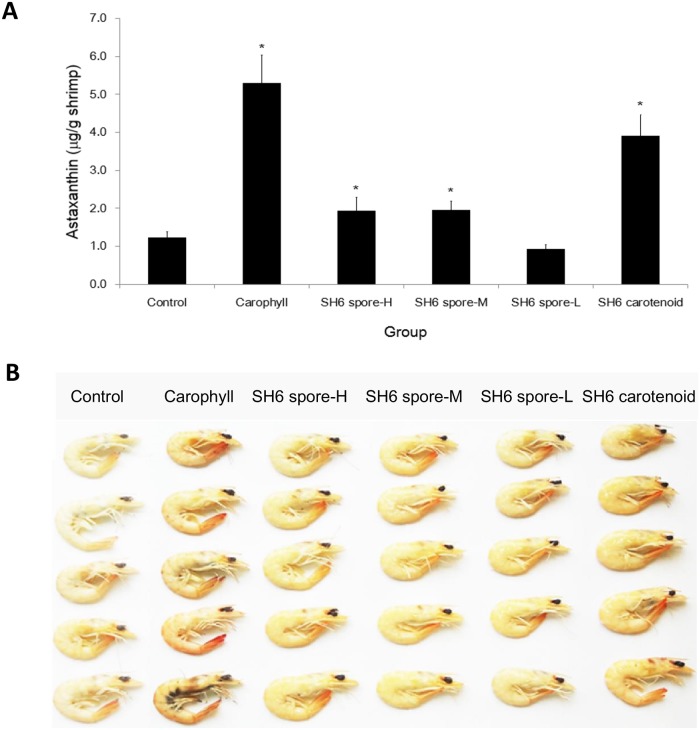
Astaxanthin concentration and colour in L. vannamei after 28 d feeding with SH6 spores.Experiment includes negative control, Carophyll (astaxanthin: 0.5 mg/g pellet), SH6 carotenoid (SH6 carotenoids: 5 μg/g pellet), and SH6 spore-H/M/L groups (SH6 spores at 5 × 106, 1 × 106, 2 × 105 CFU/g pellet, respectively). (A) Astaxanthin concentrations in shrimp muscles (μg/g shrimp). Data are presented as arithmetic means and error bars are standard deviations (n = 5). P values were generated using Student’s t-test for multiple comparisons to the control (*P <0.05; **P <0.01). (B) Image of boiled shrimps and their variable colour scores indicating the levels of red pigmentation (n = 5).